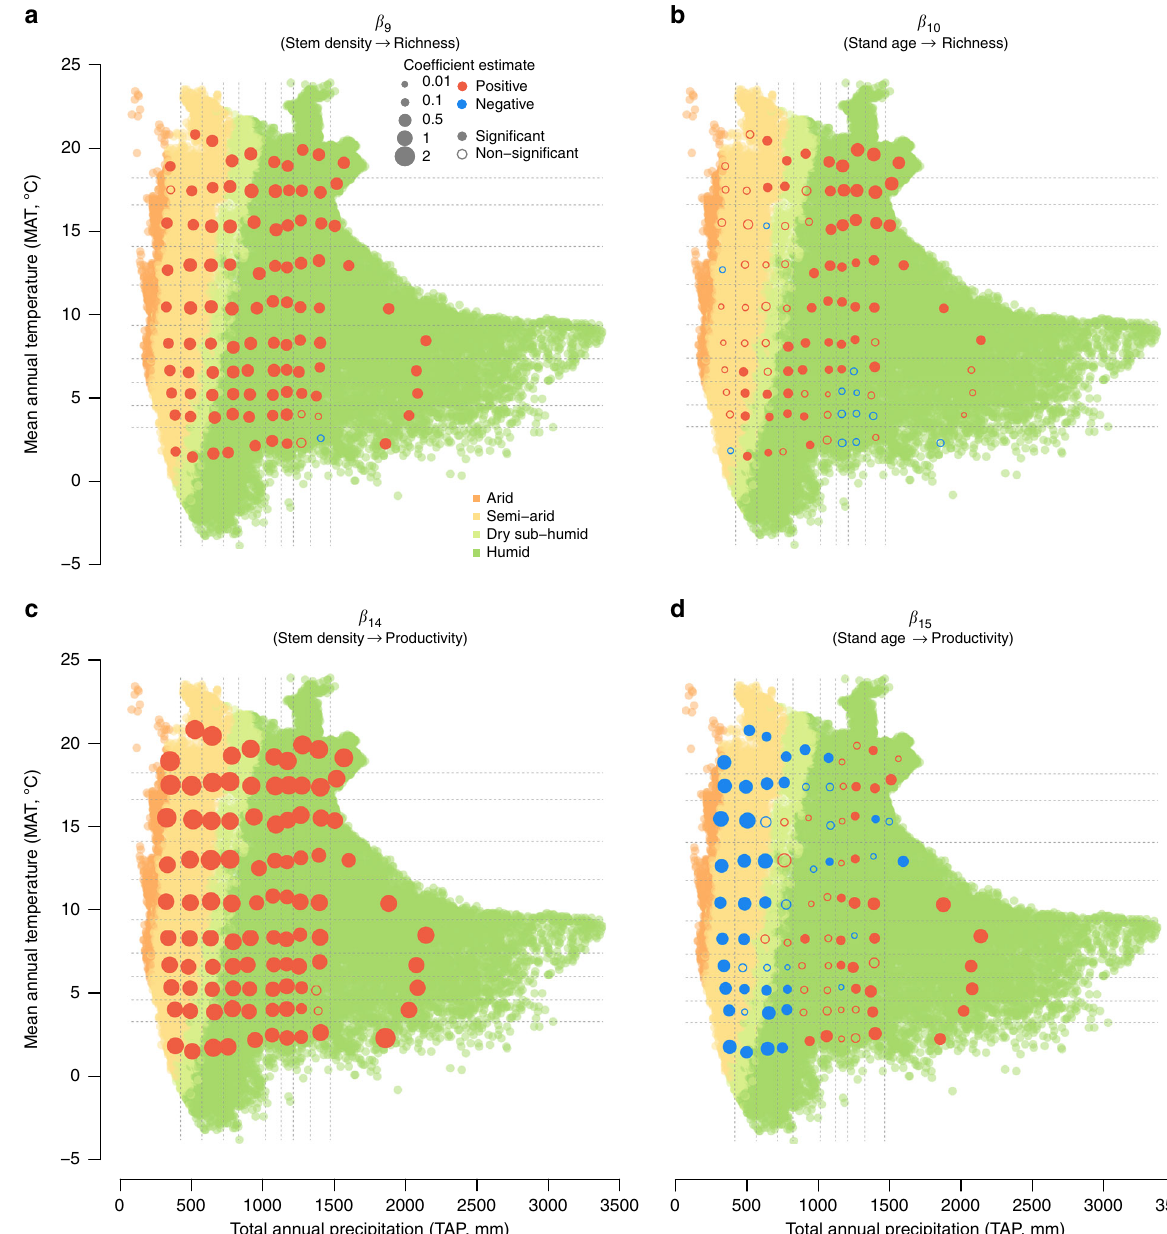
Fig. 5 Impacts of stand characteristics on richness and productivity in different climates. a Impacts of stem density on richness, b impacts of stand age on richness, c impacts of stem density on productivity, and d impacts of stand age on productivity. Coef fi cient estimates of the relationship for each climatic unit is plotted based on the means of MAT and TAP within the climatic unit on the MAT-TAP space illustrated in Fig. 1. Signi fi cance of the coef fi cient is evaluated based on whether the 95% credible interval (CI) overlaps zero. A list of coef fi cient estimates with its 95% CI is available in Supplementary Data